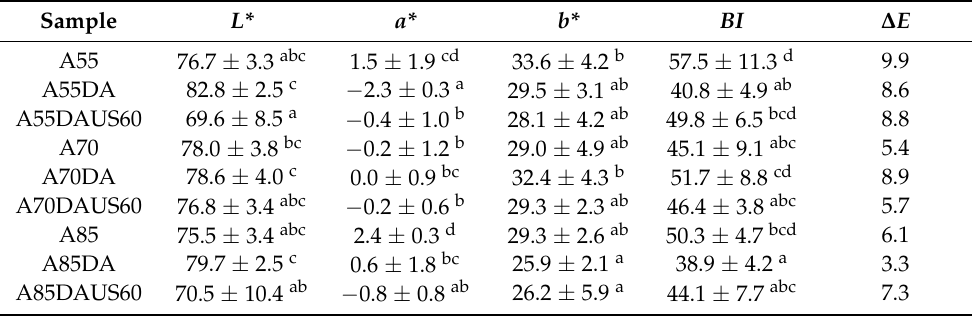
Table 2. The color of the dried apples obtained by the convective method with non-dehumidified air (A55, A70, A85), dehumidified air (A55DA, A70DA, A85DA), and dehumidified air with ultrasound pretreatment (A55DAUS60, A70DAUS60, A85DAUS60); the same letters (a, b, etc.) in the columns represent homogeneous groups in statistical terms ( α = 0.05).